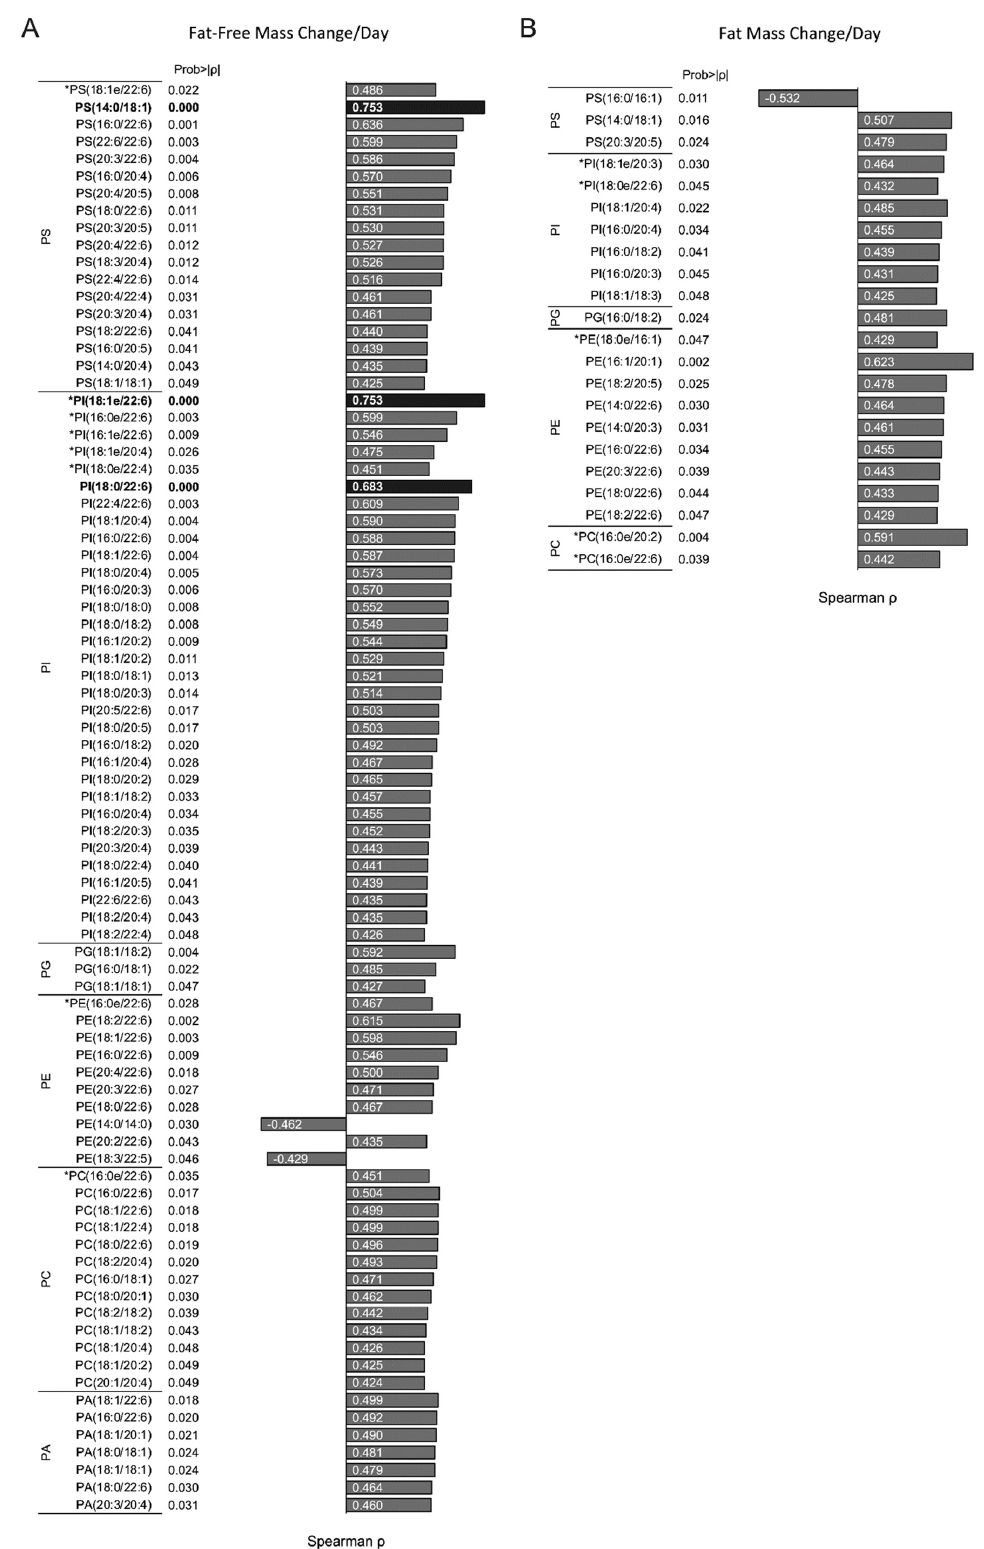
Figure 3. Individual infant RBC phospholipids that correlate with infant ∆ -FFM and ∆ -FM changes per day. ( A ) Of the nearly 500 individual phospholipids measured, 81 were significantly positively correlated with p < 0.05 with ∆ -FFM/day, and PS(14:0/18:1), PI(18:1e/22:6), and PI(18:0/22:6) were the most highly significant (boldface yellow). ( B ) Only 22 individual phospholipid species were significantly correlated with infant ∆ -FM/day, but none were correlated with p < 0.0001 criteria. * denotes plasmalogen